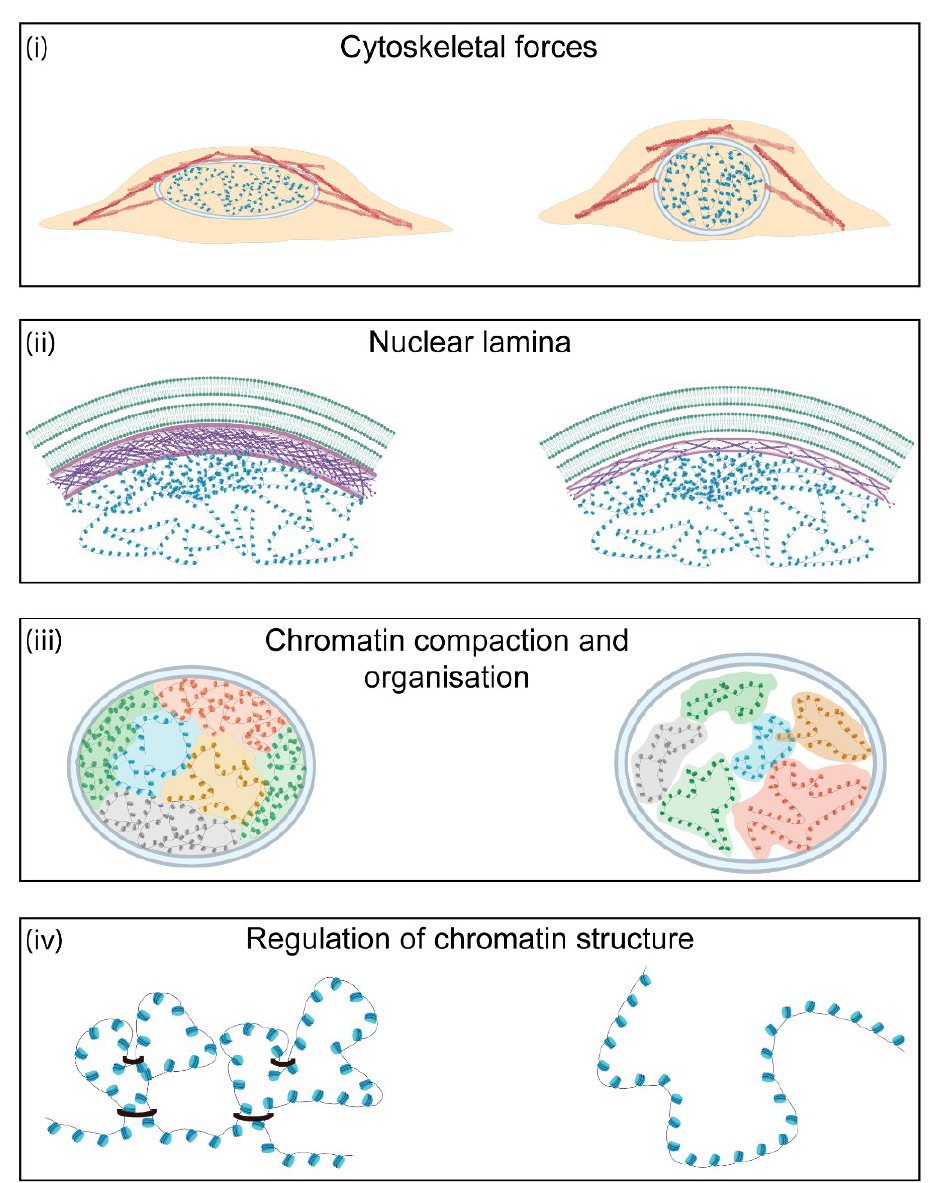
Figure 2. Major contributors to nuclear morphology and mechanics. There are four major contribu- tors to nuclear mechanics in the cell. (i) Cytoskeletal forces determine nuclear shape and morphology. Increased actin polymerisation leads to higher nuclear tension. (ii) The nuclear lamina is one of the major contributors to nuclear stiffness. This meshwork of intermediary filaments at the nuclear pe- riphery is important for nuclear stability and chromatin organisation. Higher levels of lamin A/C or a thicker nuclear lamina lead to increased nuclear stiffness. (iii) Chromatin behaves as a crosslinked polymer gel. As a result, changes in chromatin organisation and levels of heterochromatin and euchromatin directly affect nuclear shape and mechanics. (iv) Regulation of chromatin architecture is dependent on the activity of several factors, such as cohesins, that allow crosslinking of chromatin and the formation of higher-order structures. The activity of these proteins can affect local and global chromatin conformation and, hence, is important for nuclear